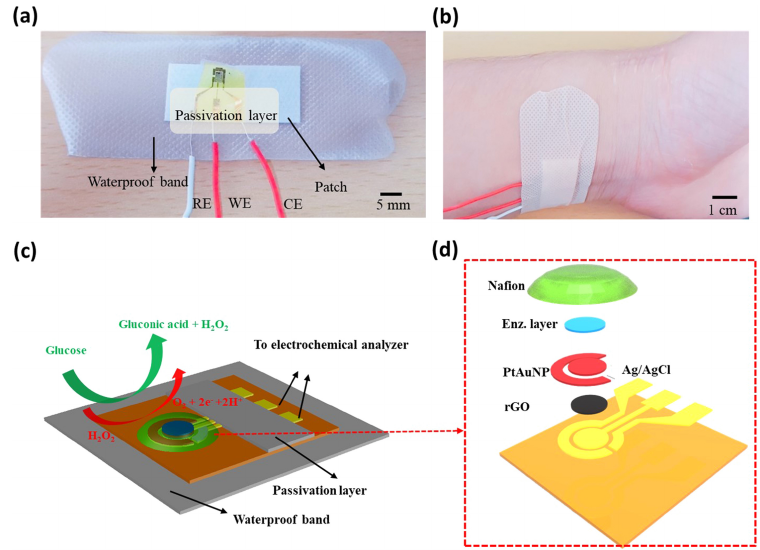
Figure 1. Photos and schematic of the glucose sensor ( a ) Picture of the sensor; ( b ) Sensor mounted on the body; ( c ) Schematic explaining the sensing mechanism; ( d ) Exploded view. Reprinted with permission from Ref. [64].